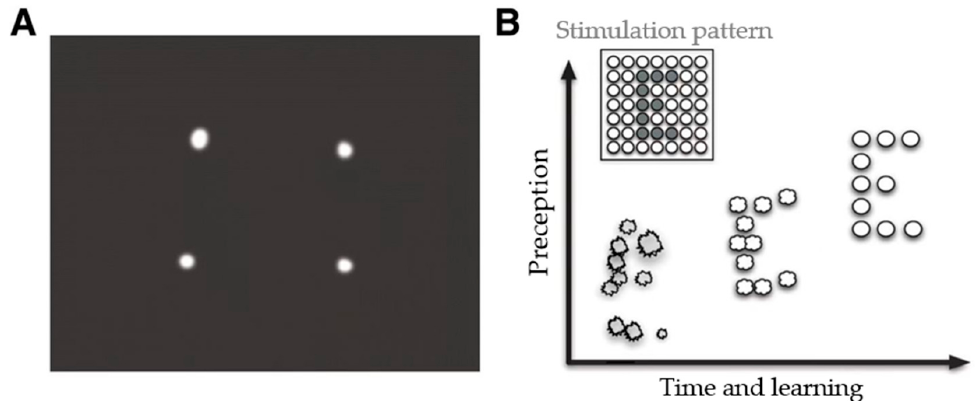
Figure 3. Schematic diagram of poor phosphenes induced by CORTIVIS electrode implantation. ( A ) Simultaneous stimulation of four electrodes arranged in a square may produce the perception; ( B ) Immediately after implantation, the induced phosphenes may cause poor perception of objects, such as the letter “E” in the figure. However, appropriate learning and rehabilitation strategies can help to improve the poor perception (adapted from [66]).